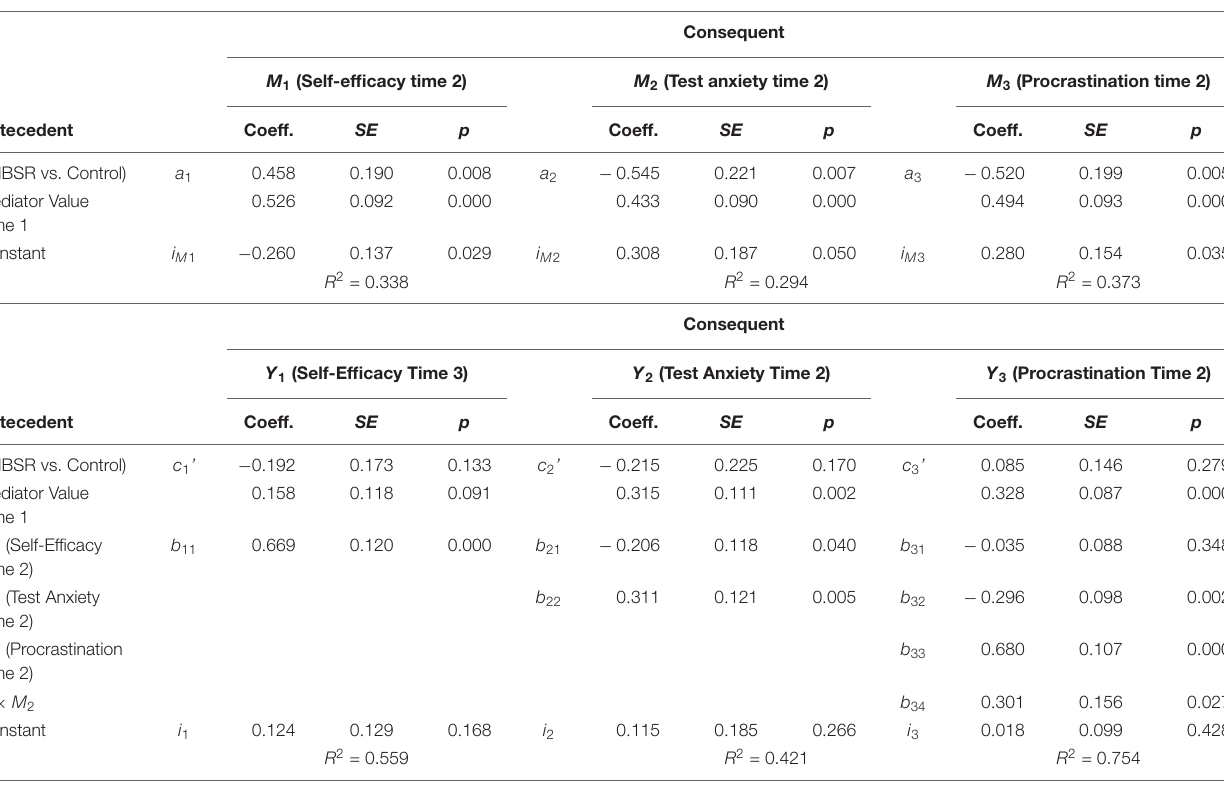
TABLE 5 | Regression coefficients, standard errors, and model summary information for the conditional parallel multiple mediation models for academic procrastination measured at time